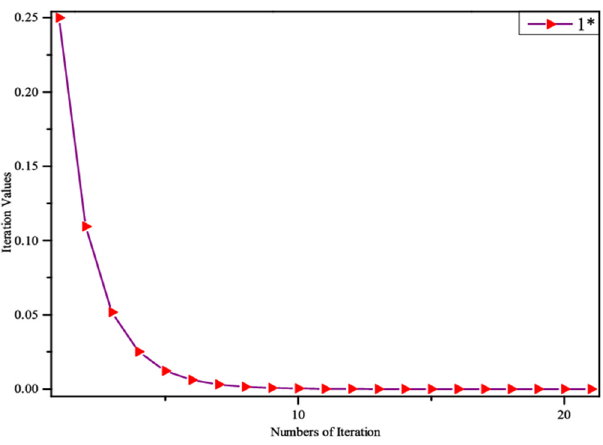
Figure 2. Represents convergence behavior of ǁ s n +1 ( x ) − 0 ǁ 2 for the initial value s 0 ( x ) = x .